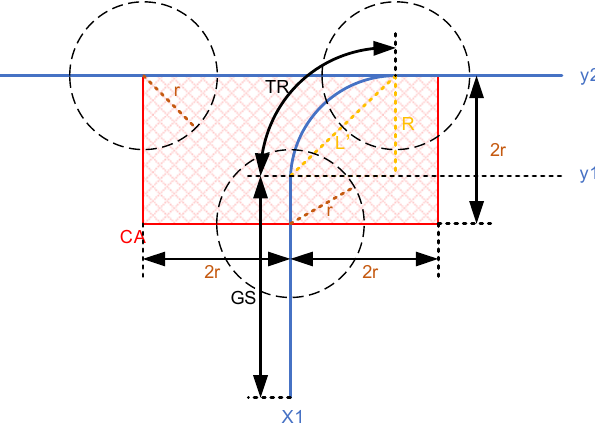
Figure 5. The latent collision area of two vehicles.